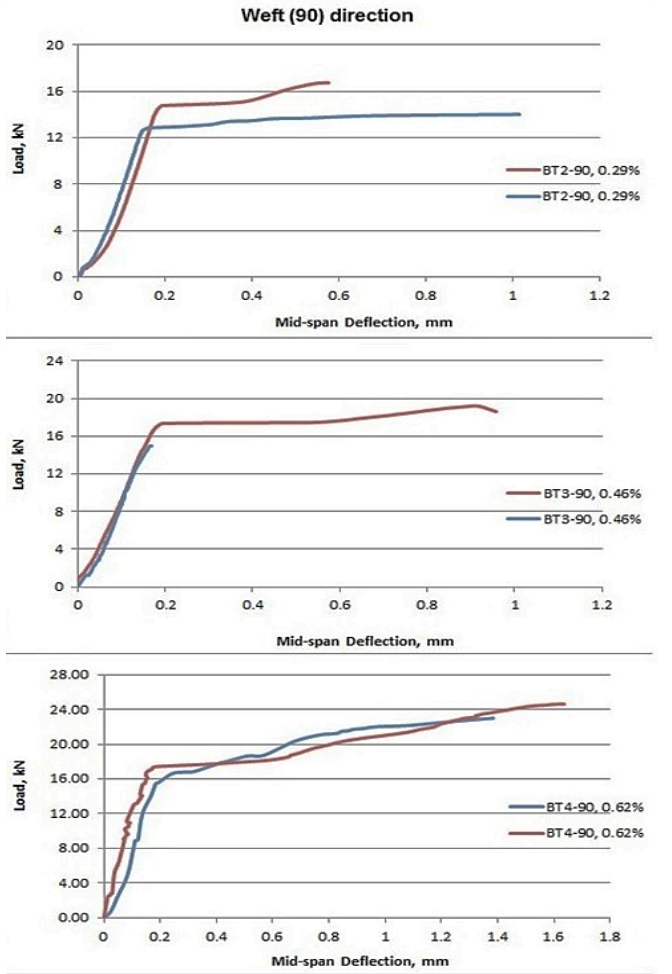
Figure 7. Mid-span load-deflection of TRC beams with woven fabric (2.5 cm) in the weft direction.